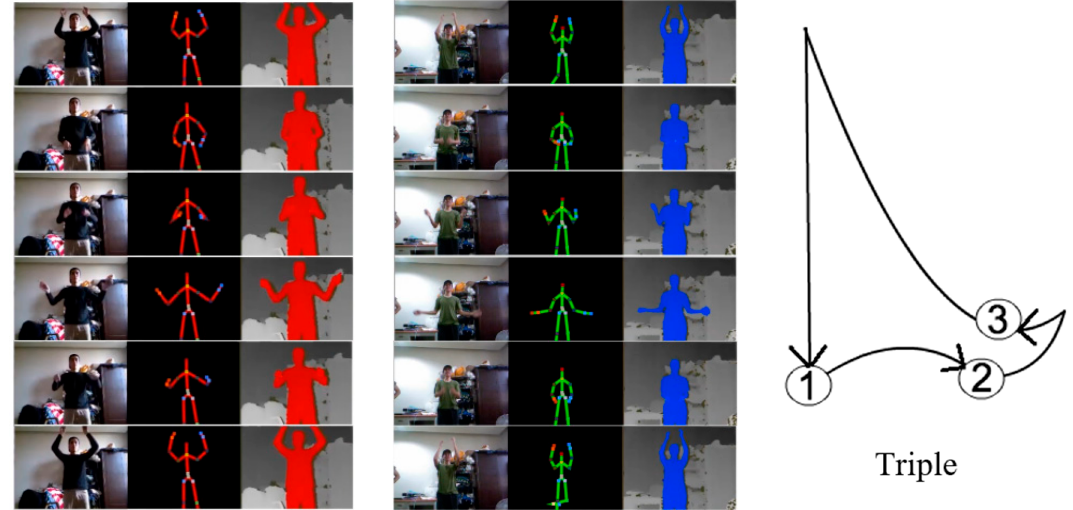
Figure 14. Screenshots of a single musical conducting gesture (duple) being made while facing the camera, including the 2D video, a skeleton model of the musical conductor, and the depth video.